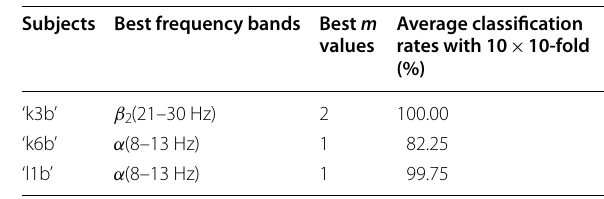
Table 1 Summarization of the best parameters for all subjects on Dataset